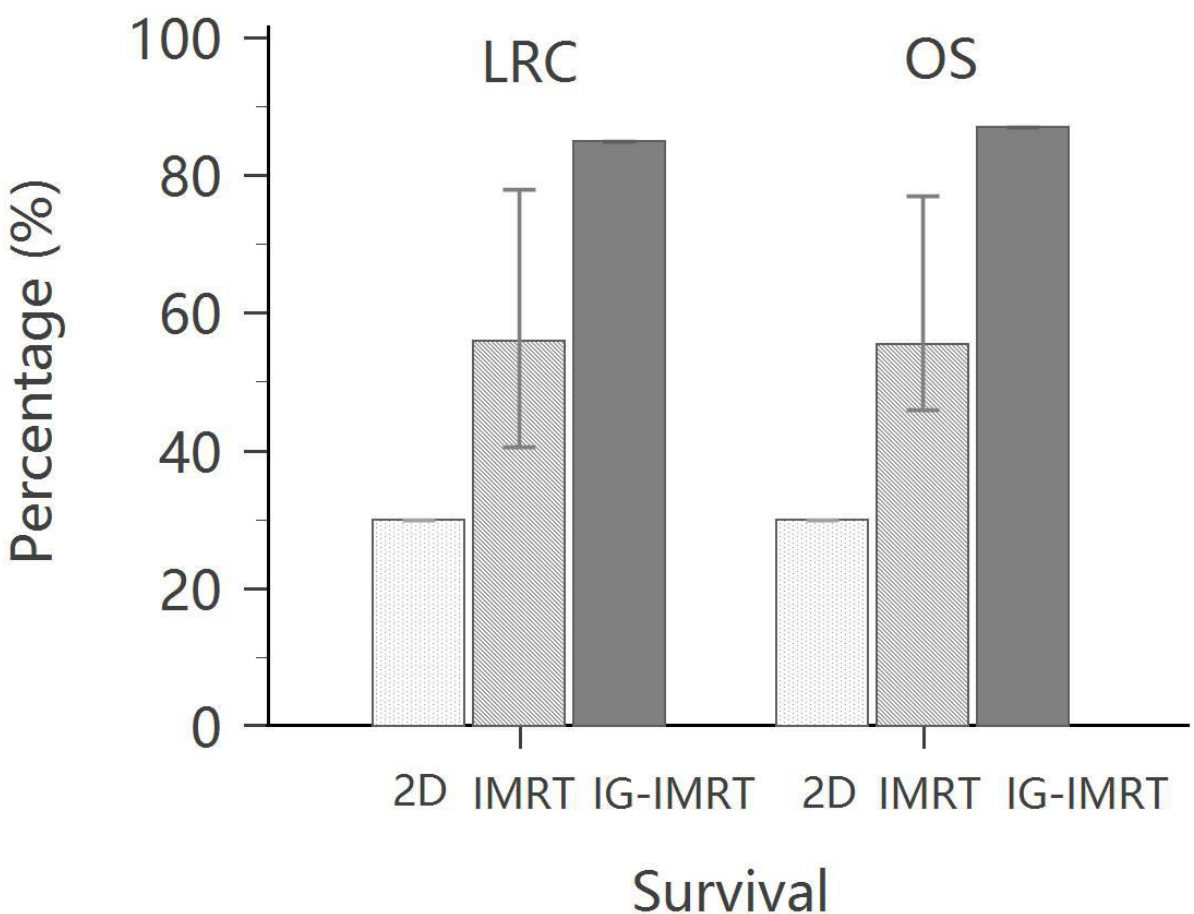
Figure 2. The comparison of local regional control rate and overall survival rate between 2D, intensity- modulated radiotherapy (IMRT) and image-guided (IG)-IMRT for patients with head and neck